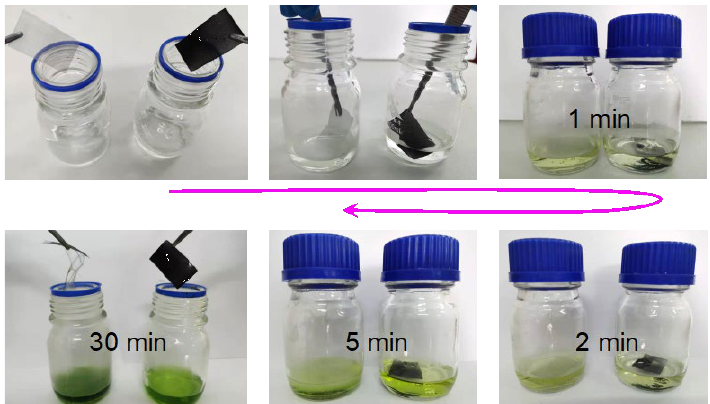
Figure 6. Comparison of anti-corrosive behavior for the uncoated stainless steel mesh and the 1 min double-faced superhydrophobic mesh coated with PVDF/CS in concentrated HCl